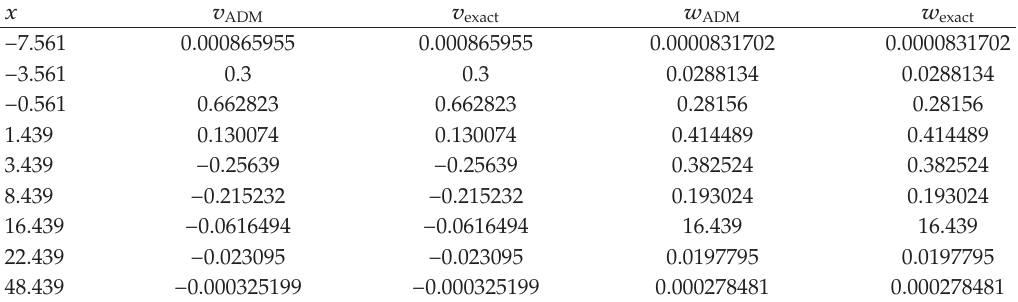
Table 2: Comparison between the exact solutions and approximation solutions (cid:2) ADM (cid:3) for FN equations at time (cid:8) 5.